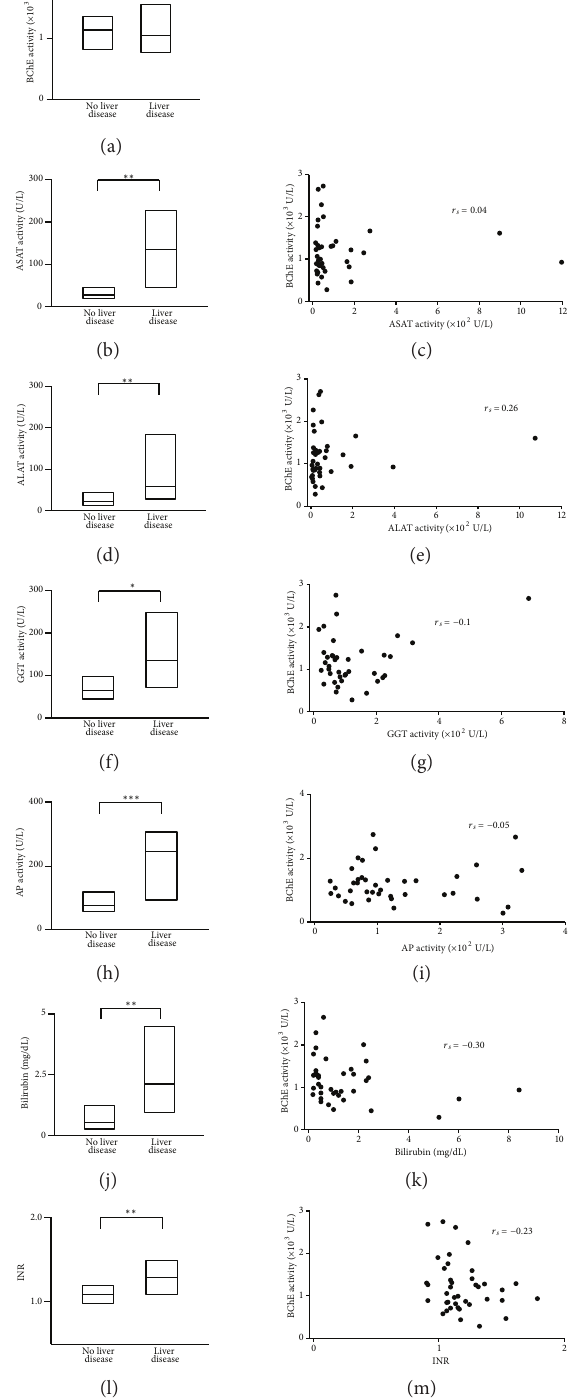
Figure 3: POCT-measured BChE activity during systemic inflammation remains disrupted, independent of the patient liver function. Box plots represent median values and 25%–75% percentile of the POCT-measured BChE activity ( 𝑛 = 40 measurements (a)) and standard laboratory tests for ASAT ( 𝑛 = 39 measurements (b)), ALAT ( 𝑛 = 39 measurements (d)), GGT ( 𝑛 = 39 measurements, f), AP ( 𝑛 = 39 measurements (h)) activity, total serum bilirubin concentration ( 𝑛 = 38 measurements (j)), and INR coagulation test ( 𝑛 = 40 measurements (l)) in patients with systemic inflammation associated with (liver disease) or without (no liver disease) hepatic dysfunction. Scatter plots represent the correlation degree between POCT-measured BChE activity and the corresponding ASAT (c), ALAT (e), GGT (g), AP (i) activity,bilirubinconcentration(k),andINR(m).ASAT:aspartateaminotransferase;ALAT:alanineaminotransferase;GGT:gammaglutamyl transpeptidase; AP: alkaline phosphatase; INR: international normalized ratio. ∗ 𝑃 < 0.05 , ∗∗ 𝑃 < 0.01 , and ∗∗∗ 𝑃 < 0.001 (Mann-Whitney test); 𝑟 𝑠 : Spearman correlation